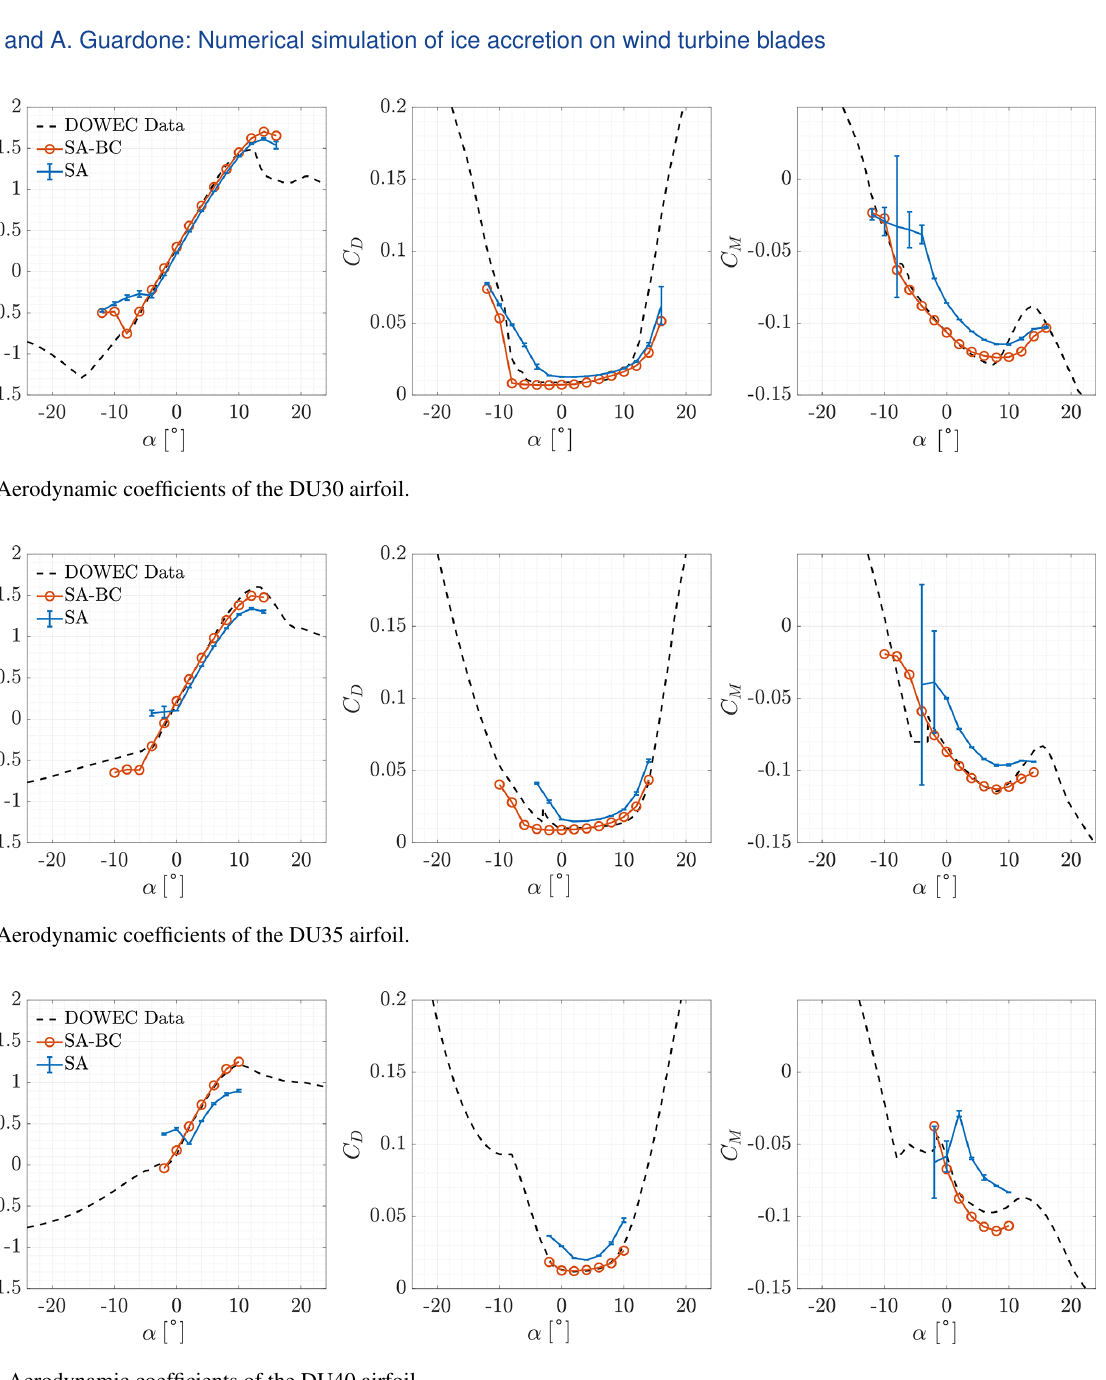
Figure 10. Aerodynamic coefficients of the DU40